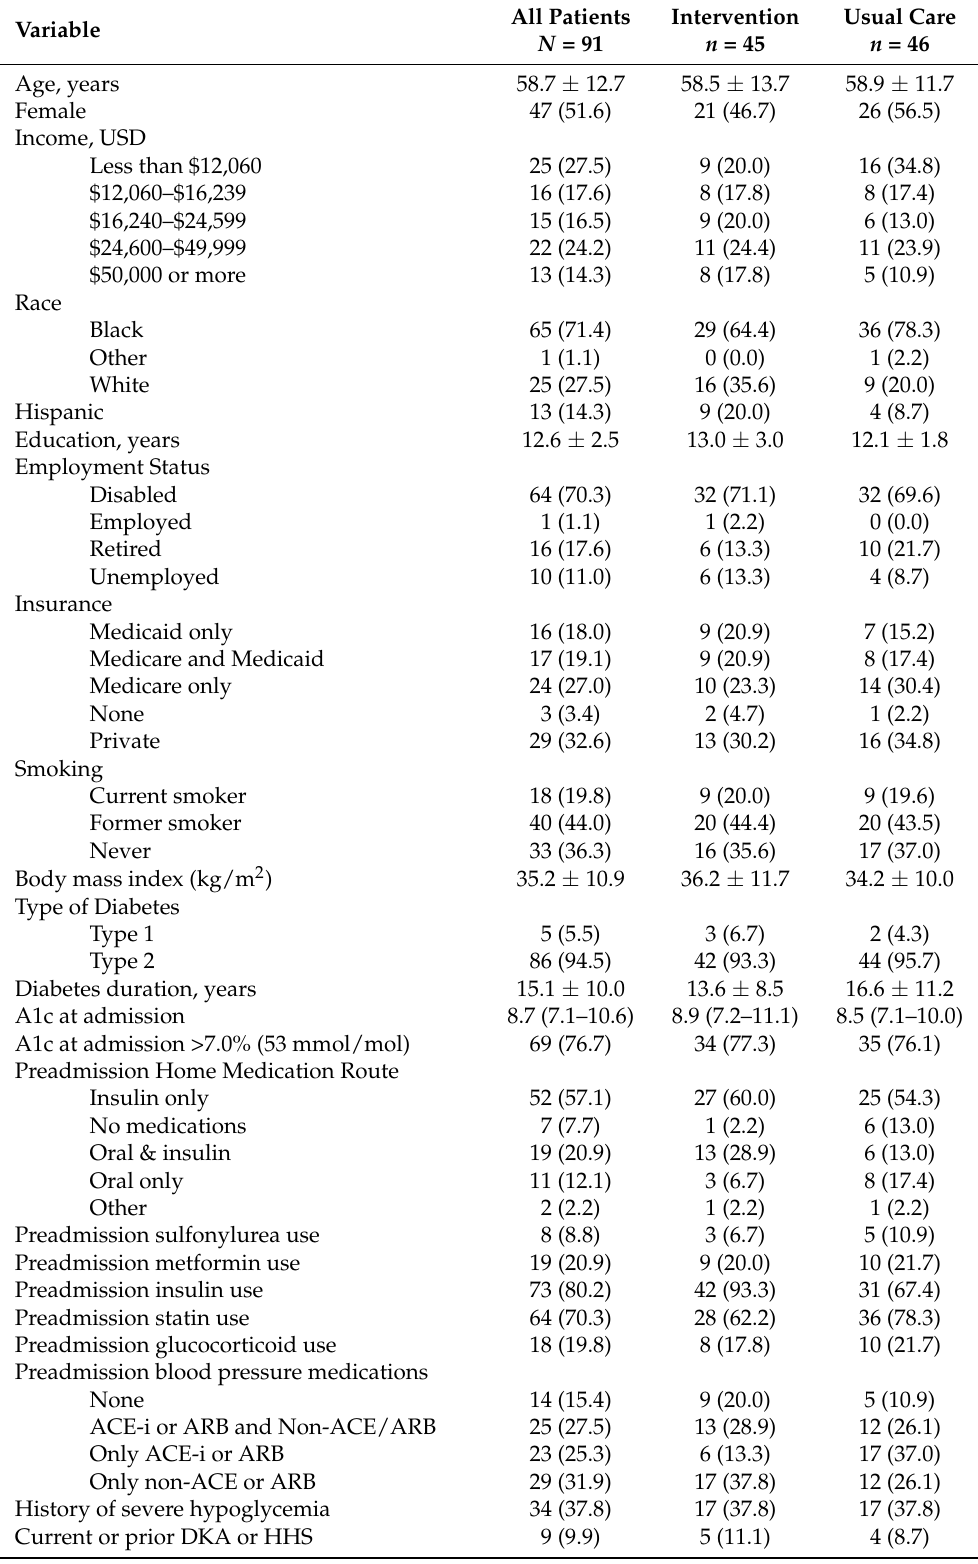
Table 1. Baseline characteristics of Intervention and Usual Care